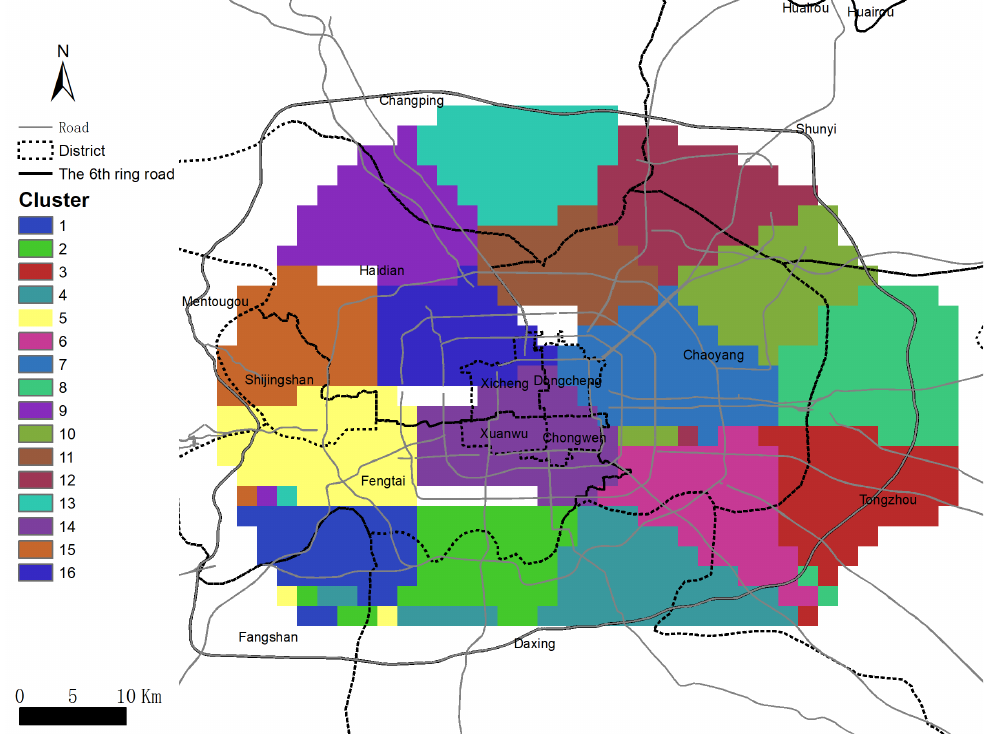
Figure 3. Boundaries of housing (sub-)markets in